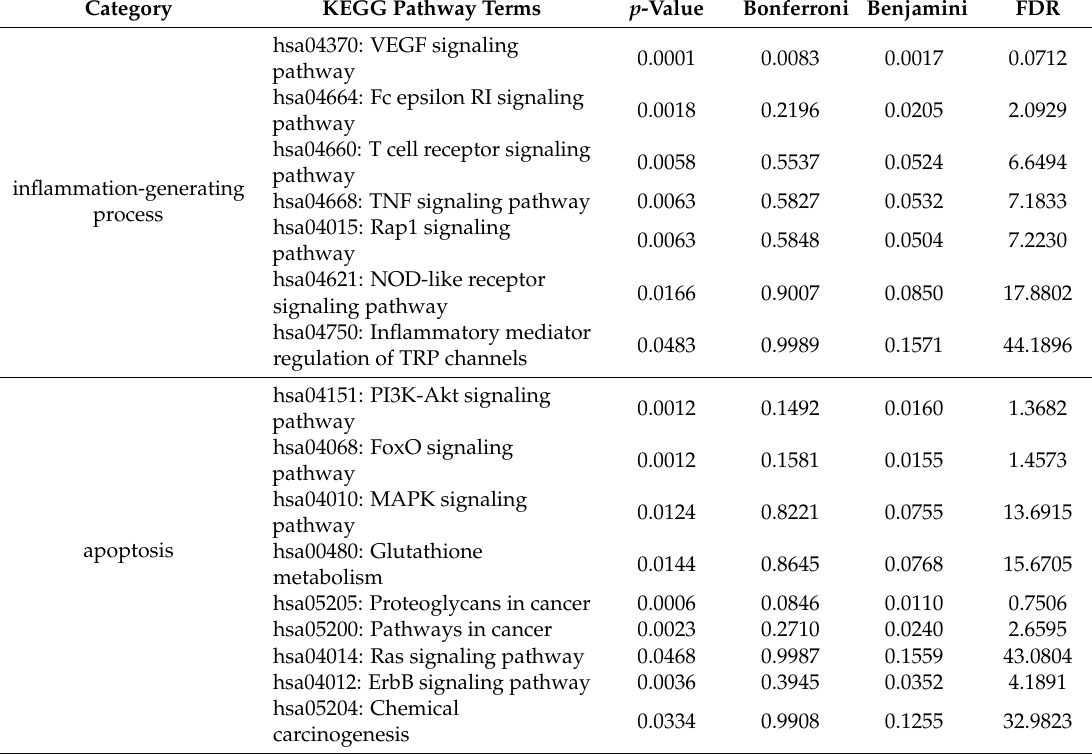
Table 2. The classification results of KEGG pathway enrichment